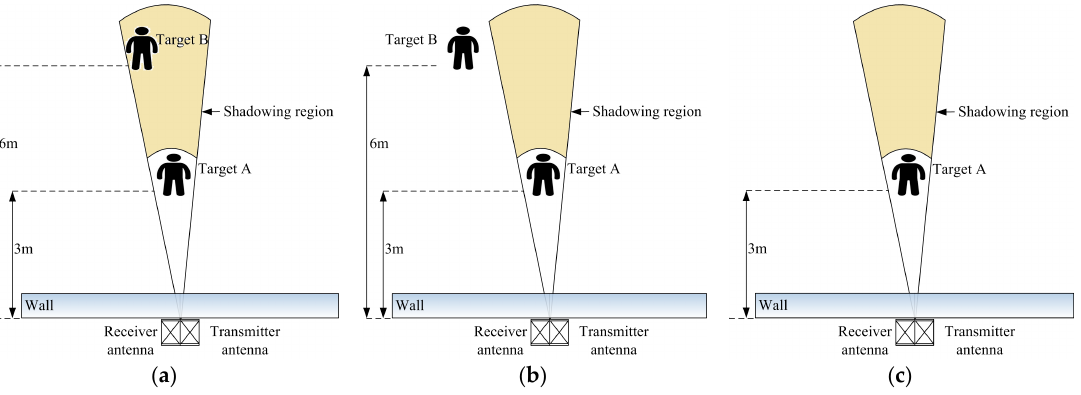
Figure 3. ( a ) Target A stood at 3 m in front of the antennas, while target B stood at 6 m in the shadowing region of target A; ( b ) target A stood at 3 m in front of the antennas, while target B stood at 6 m out of the shadowing region; and ( c ) target A stood at 3 m in front of the radar antennas.